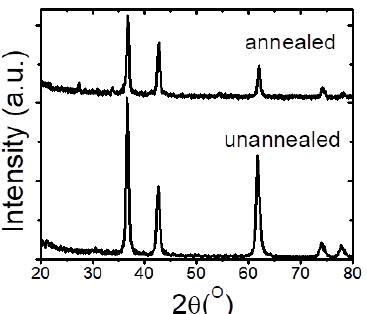
Figure 3. XRD data of Sample C, before and after 700 °C annealing in N 2 . TiN was grown on a sapphire substrate for 30 min.